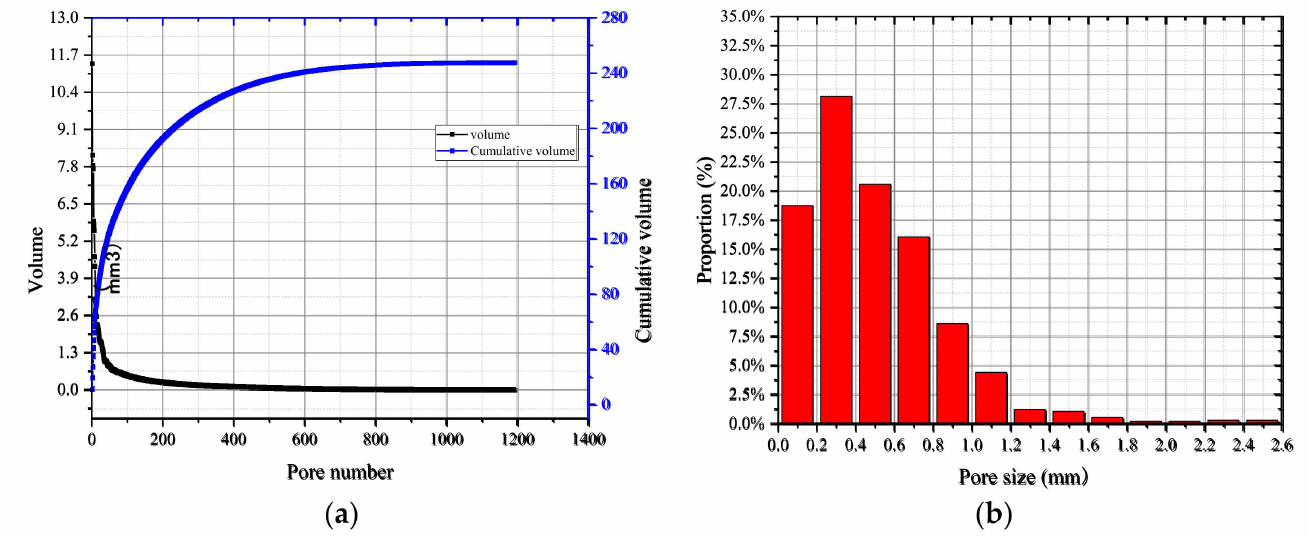
Figure 16. Statistical curves of pore distribution: ( a ) pore volume and cumulative volume distribution curves; ( b ) proportion of the pore